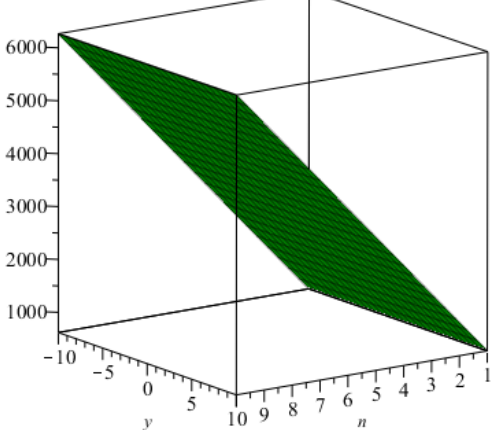
Figure 5. The graphical representation of the augmented Zagreb